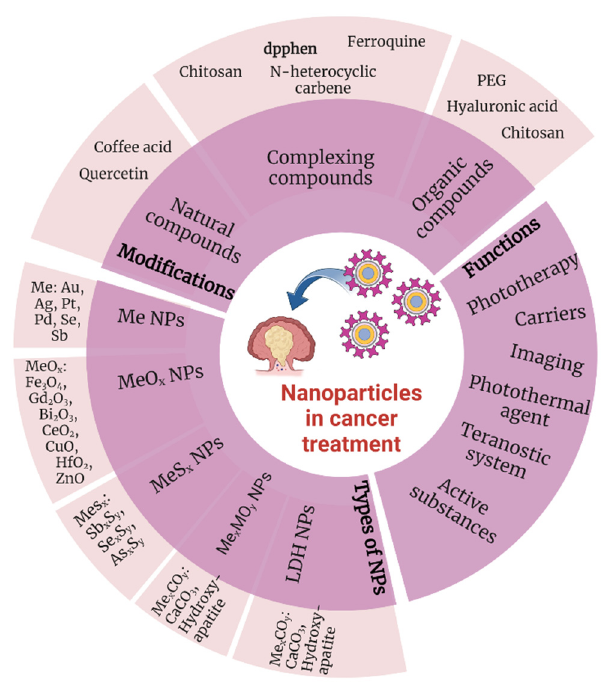
Figure 2. Chemical substances and their functions in cancer treatment (Created with BioRender.com, access: 27 February 2023).